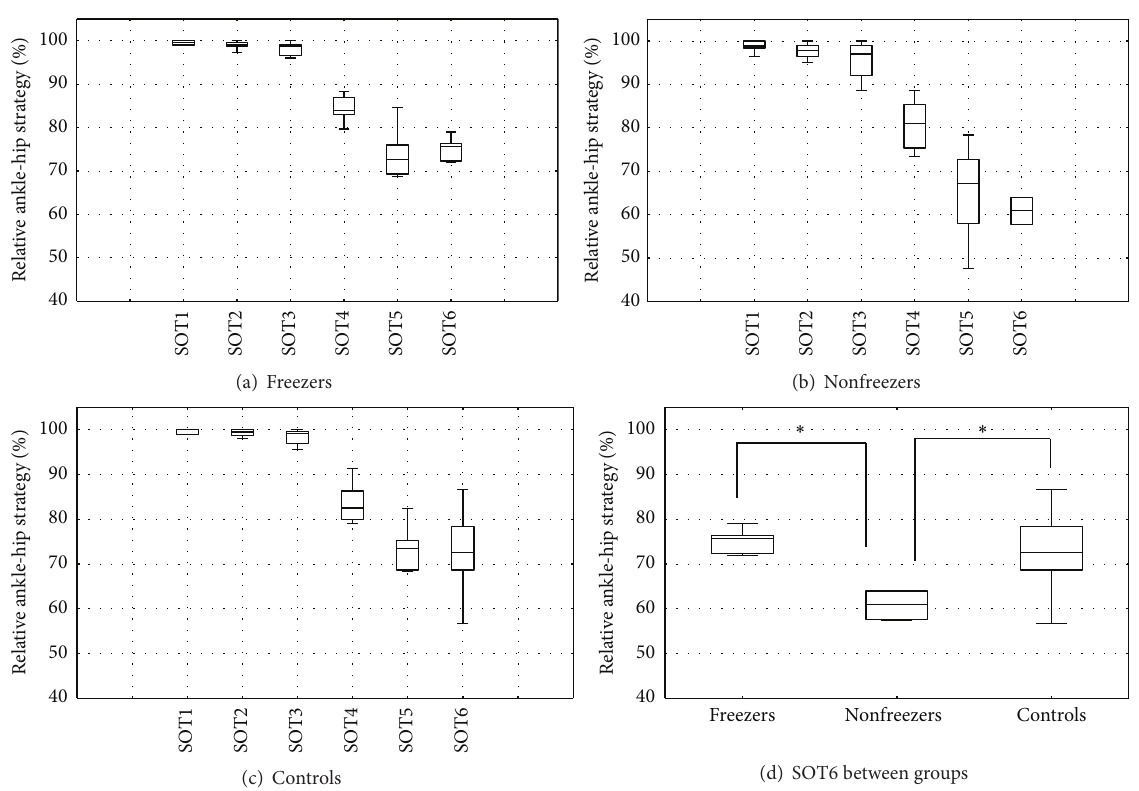
Figure 1: Group comparison of ankle-hip strategy in SOT conditions. Boxes represent median values and interquartile ranges (Q25–Q75), with error bars indicating the nonoutlier ranges. Panels (a), (b), and (c) show the relative ankle-hip strategy (with 100% ankle strategy only and 0% hip strategy only) for each SOT test. Panel (d) shows the relative ankle-hip strategy for SOT6 between freezers, nonfreezers, and controls. ∗ Significant difference ( 𝑃 < 0.05 ) between two groups (post